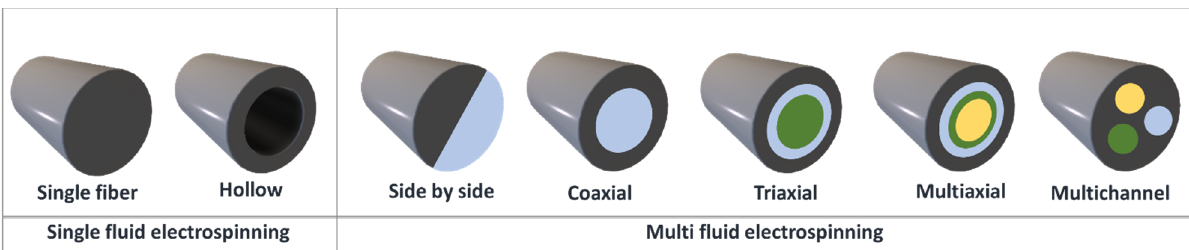
Figure 2. Schematic of the different routes to drug incorporation into a polymer carrier through electrospinning.